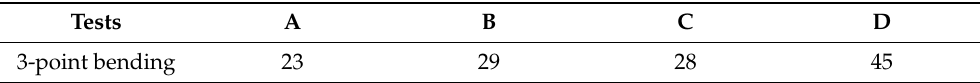
Table 5. Weibull modulus of green filaments from 3-point bending tests.